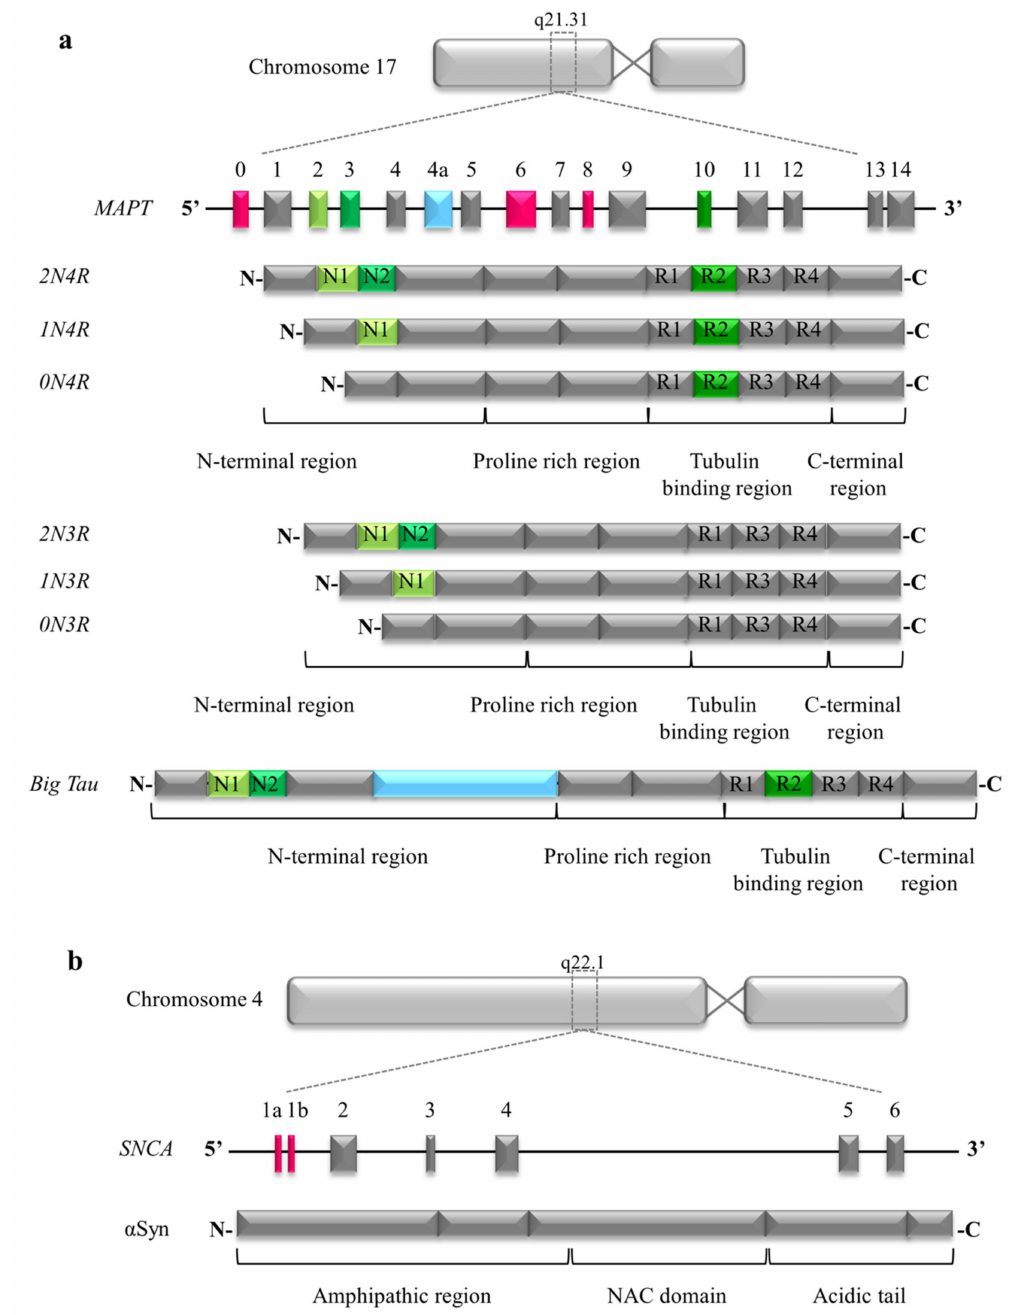
Figure 1. Gene, isoforms and functional domains of Tau and α Syn proteins. ( a ) Schematic representation of human MAPT gene present on chromosome 17. Its sixteen exons, through alternative splicing of exons 2, 3, and 10 (green), can generate 6 isoforms. Moreover, in peripheral tissue, the addition of exon 4a (light blue) generates the high molecular weight protein: Big Tau. The protein can be subdivided into 4 functional domains: N-terminal region, Proline rich region, Tubulin binding region, and C-terminal region. ( b ) Schematic representation of the SNCA gene present on chromosome 4. Exons 1a and 1b (red) are not translated. α Syn protein can be subdivided into 3 functional domains: amphipathic region, hydrophobic non-amyloid component (NAC) domain, and acidic